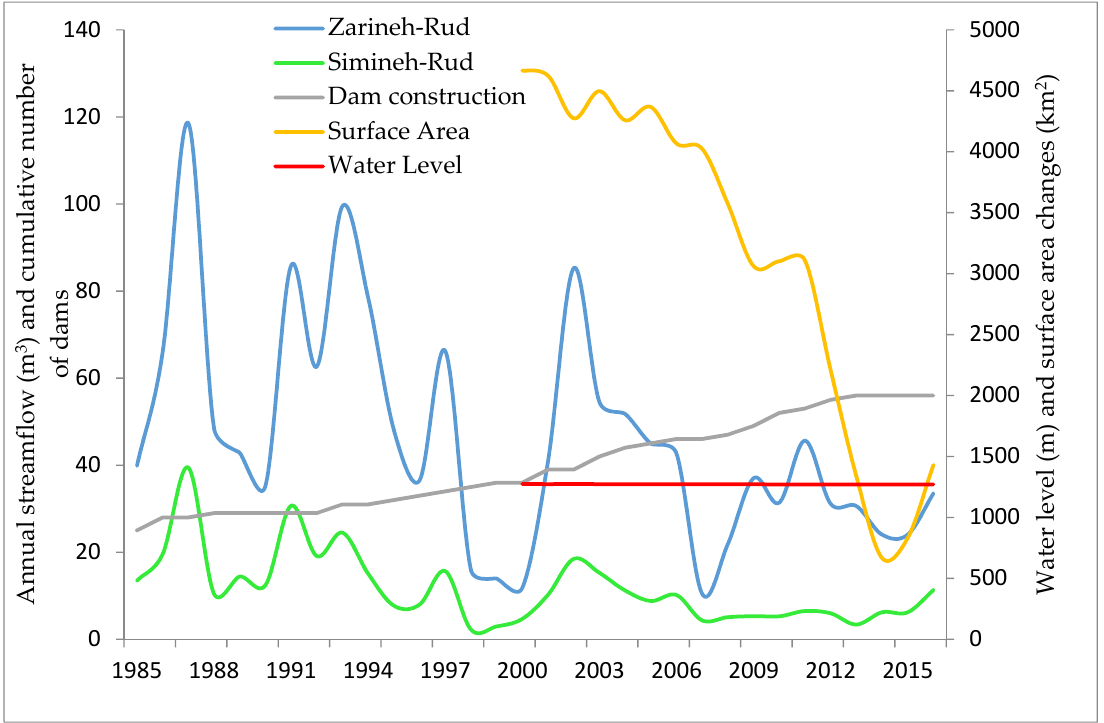
Figure 16. Number of dams constructed and annual stream flow from 1985 to 2016 and surface area and water level changes from 2000 to 2016 in the LU basin.